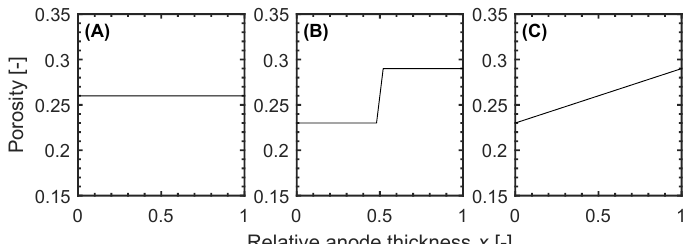
Figure 2. The three different porosity profiles used in the simulation are: ( A ) traditional constant porosity; ( B ) graded porosity; and ( C ) linearly increasing porosity. The current collector is on the left side x = 0 and the separator on the right side x = 1. A higher porosity at x = 1 is intended to postpone ion transport